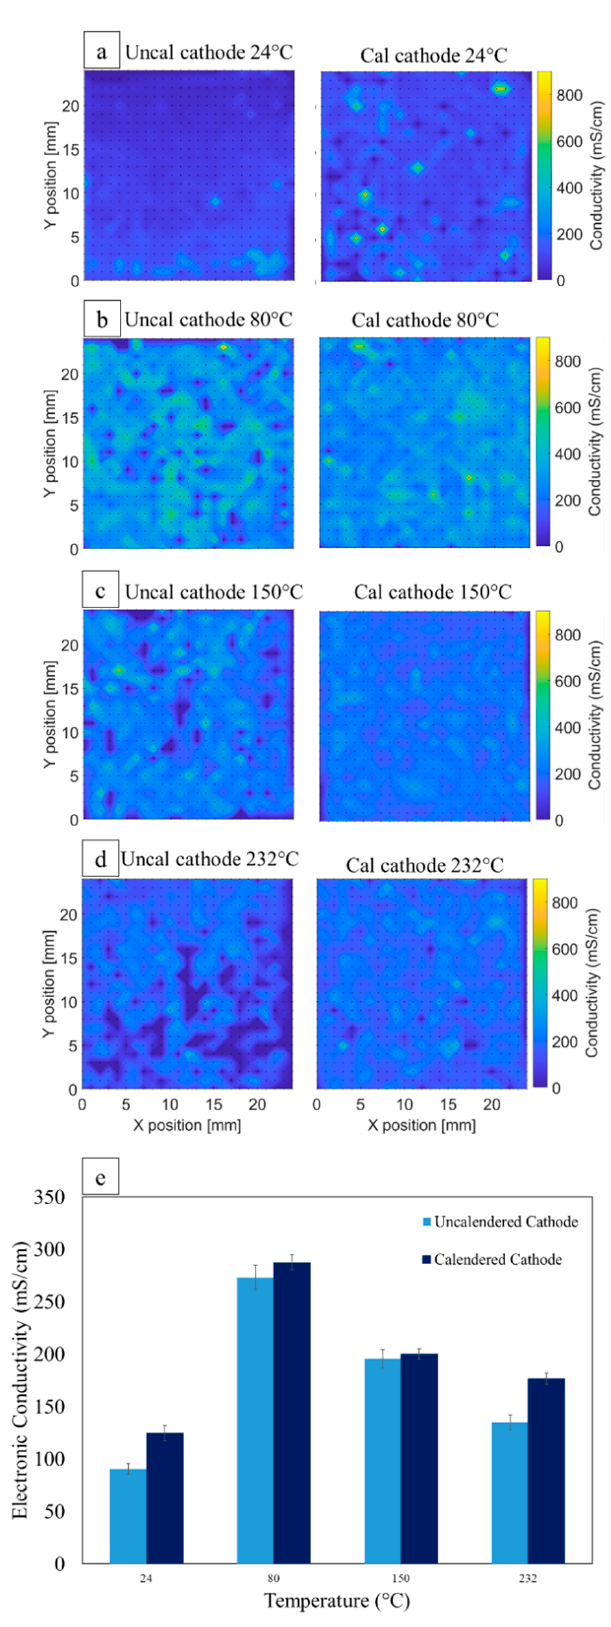
Figure 9. Electronic-conductivity maps of uncalendered and calendered cathodes dried at ( a ) 24 °C, ( b ) 80 °C, ( c ) 150 °C, and ( d ) 232 °C, and ( e ) comparison between the average electronic conductivity ( b ) 80 ◦ C, ( c ) 150 ◦ C, and ( d ) 232 ◦ C, and ( e ) comparison between the average electronic conductivity of cathodes before and after calendering. of cathodes before and after